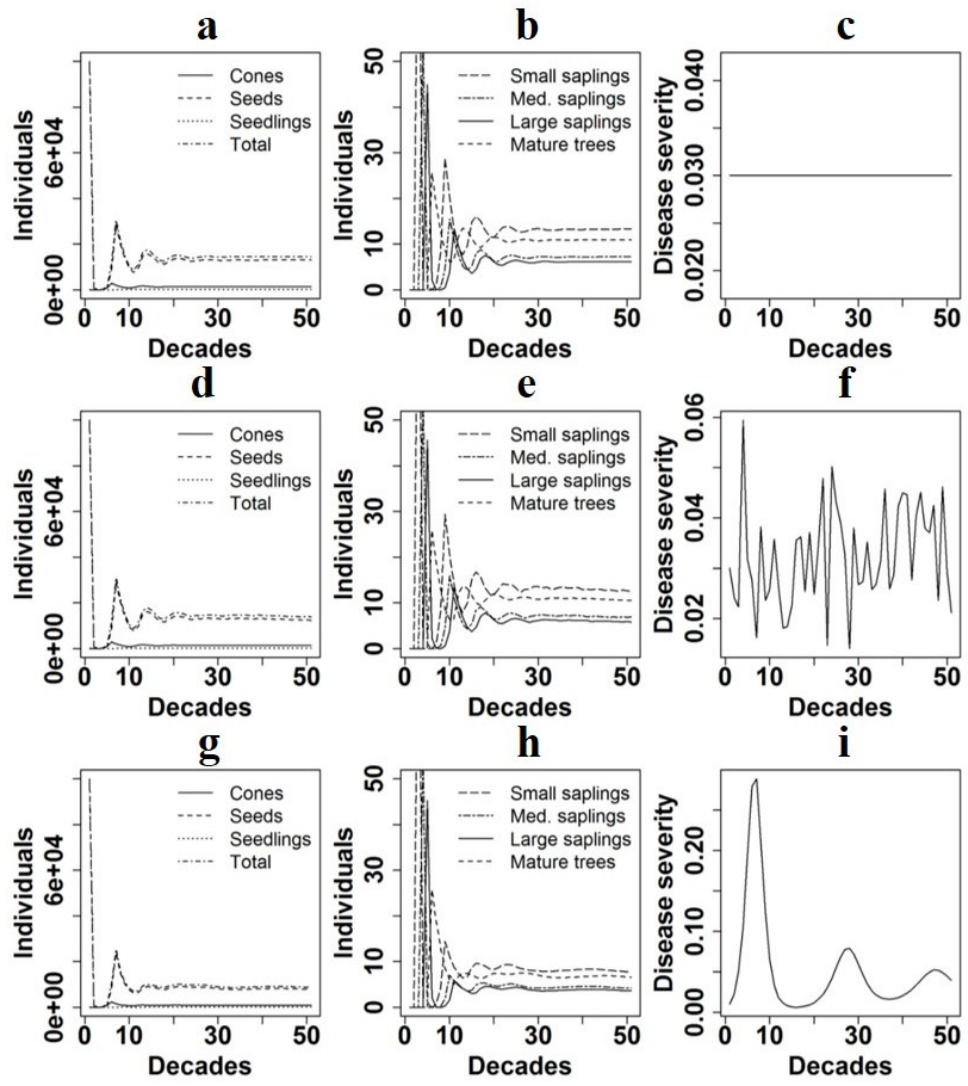
Figure 1. Example demographic projections for Monterey pine in the presence of pitch canker disease using a matrix population model. The initial population vector was representative of a stand clearing fire and consisted of seeds alone. Graphs show populations for smaller size classes and total population over time ( a , d , g ), populations of the larger size classes over time at a smaller scale to show more detail ( b , e , h ), and level of pitch canker severity over time as a proportion of infected susceptible tissue ( c , f , i ). Disease was modeled in these example projections either as constant ( a , b , c ), fluctuating over time according to a predefined beta distribution ( d , e , f ), or oscillating over time according to a feedback mechanism due to systemic acquired resistance ( g , h , i ).